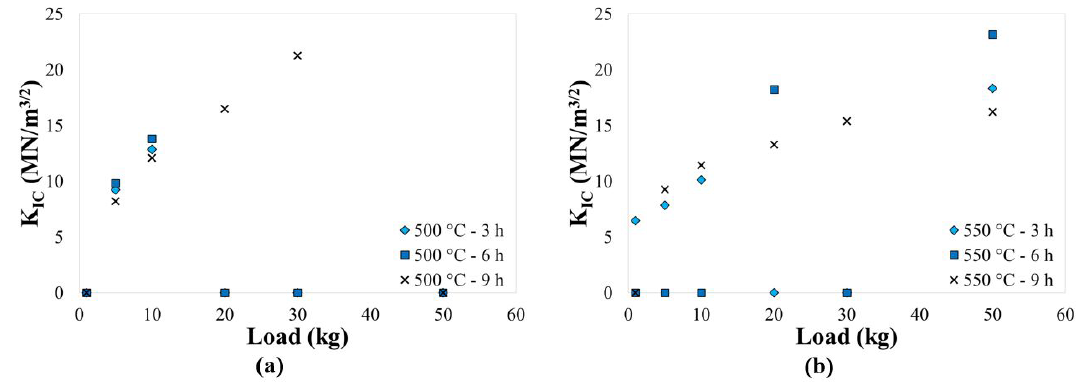
calculated for the plasma nitrided samples at temperature of (a) 500 °C and (b) 550 Fig. 4. K IC